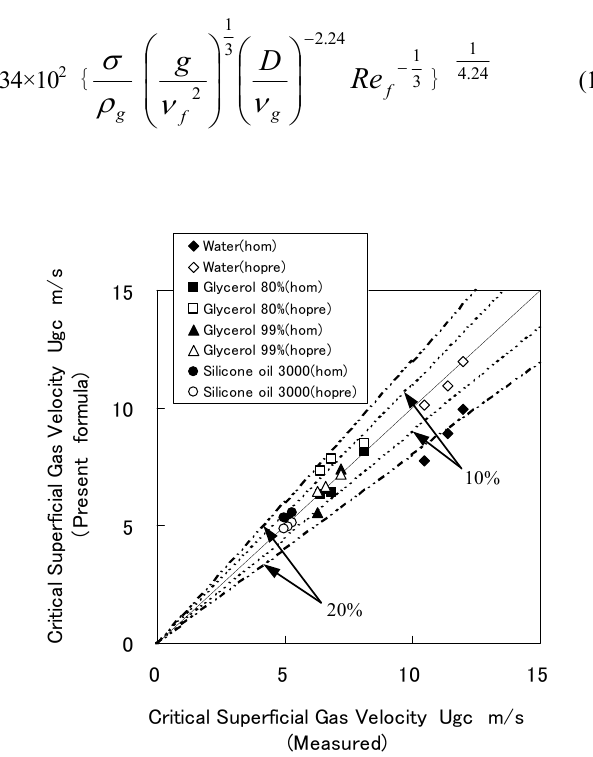
Fig.14 Comparison of critical superficial gas velocity between measured and present